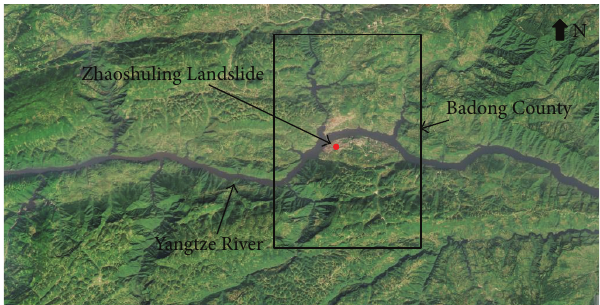
Table 1: Correspondences between 𝑃 𝑓 and 𝛽 .